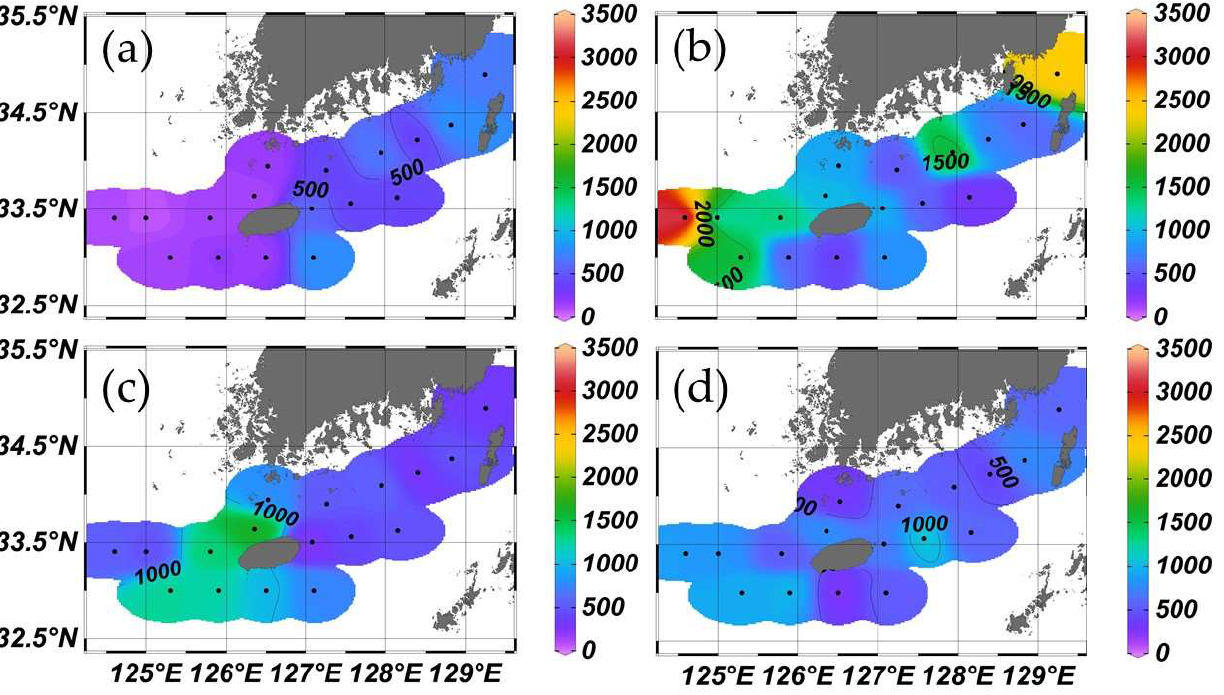
Figure 4. Distribution of copepod abundance (ind m − 3 ) at each station in ( a ) February, ( b ) April, ( c ) August, and ( d ) October 2018. The Shannon–Wiener species diversity index was in the range of 1.27–3.01 (stations 3 and 16, respectively) in February, 1.52–2.63 (stations 3 and 12, respectively) in April, 2.64–3.36 (stations 5 and 12, respectively) in August, and 2.04–3.25 (stations 1 and 17, respectively) in October (Figure